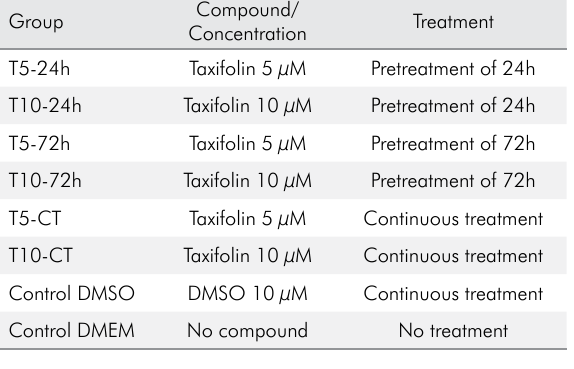
Table 1. Description of groups chosen for this study.